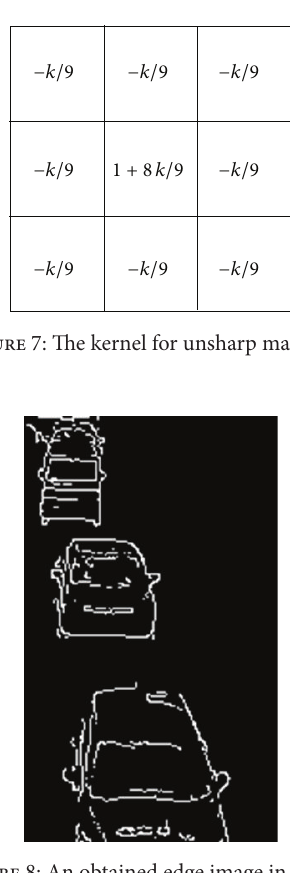
Figure 8: An obtained edge image in lane 2.